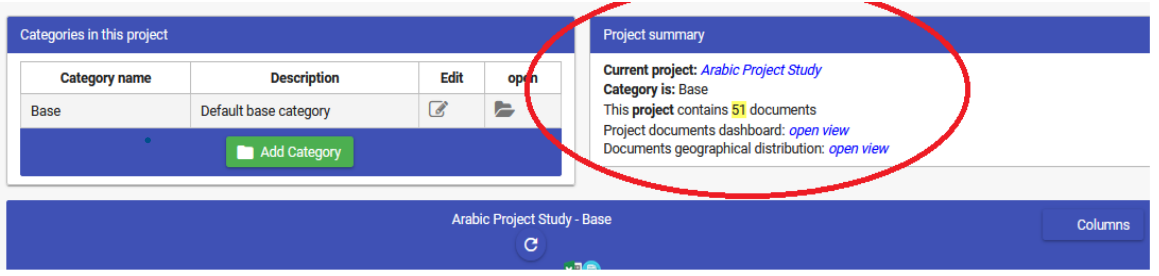
Figure 5. Topic modelling.